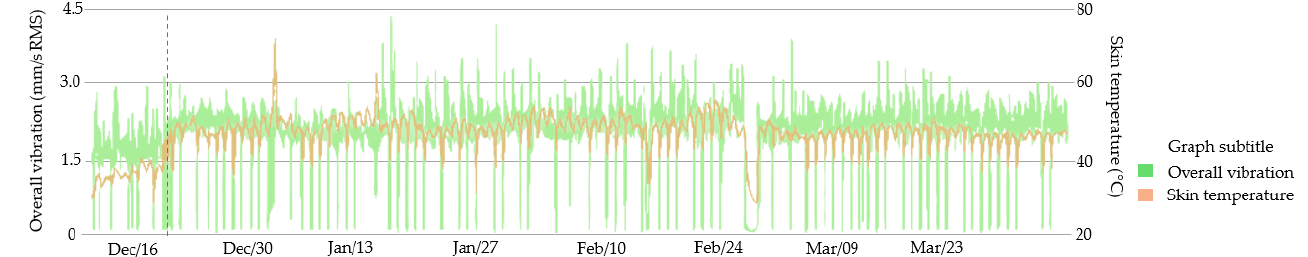
Figure 14. Motor 2 monitoring by the smart sensor.